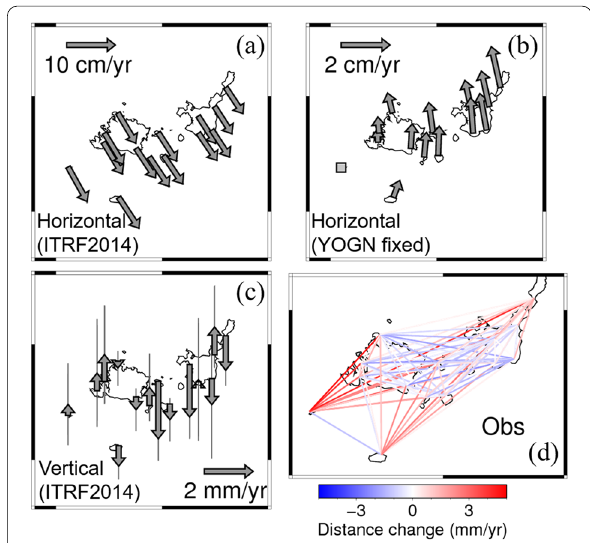
Fig. 2 Secular velocities and distance changes estimated from GNSS observations. a Horizontal component of the secular velocities in the ITRF2014. The 1 σ error ellipsoids are indicated, which are − small compared to the velocities in the horizontal components. b Horizontal velocities relative to the westernmost station, YOGN. c Vertical component of secular velocities with 1 σ error bars in − the ITRF2014. Note that the station locations are slightly moved to the horizontal direction for visibility reasons. d Distance changes between each pair of GNSS